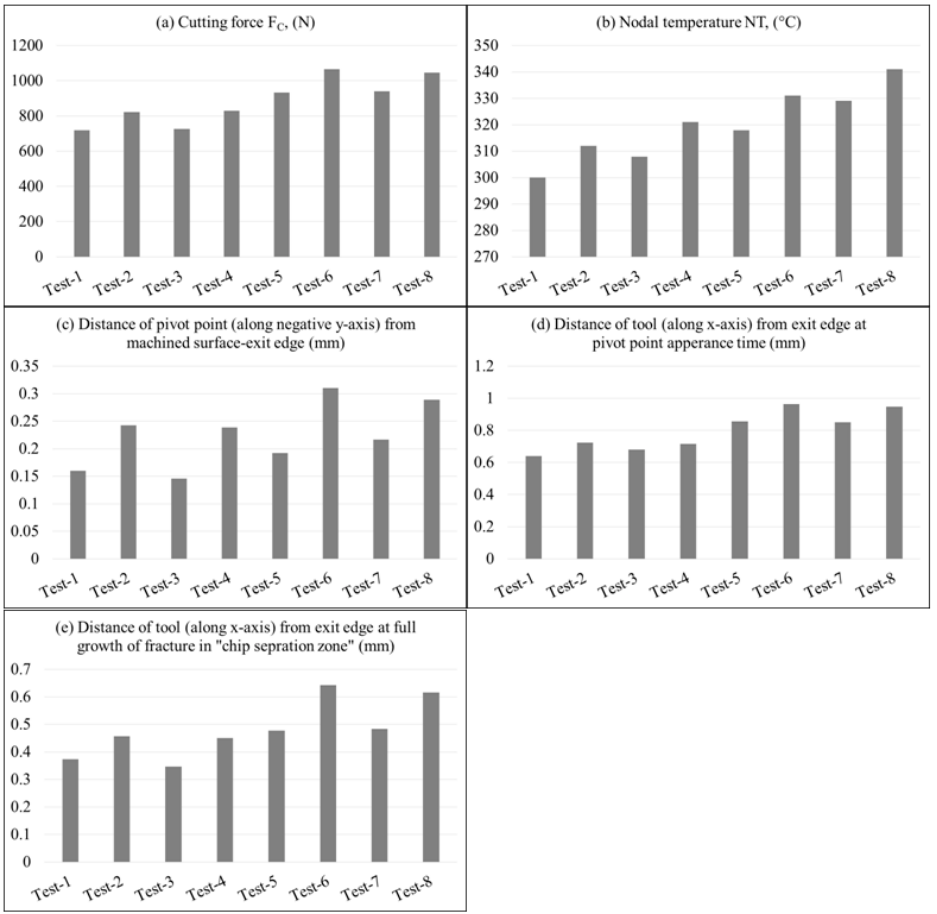
Figure 2. Computed results of various parameters for multiple combinations of cutting speed, feed rate, and rake angle ( a ) cutting force ( b ) nodal temperature ( c ) distance of pivot point (along negative y-axis) from machined surface exit edge ( d ) distance of tool (along x-axis) from exit edge at pivot point appearance time ( e ) distance of tool (along x-axis) from exit edge at full growth of fracture in “chip separation zone”.